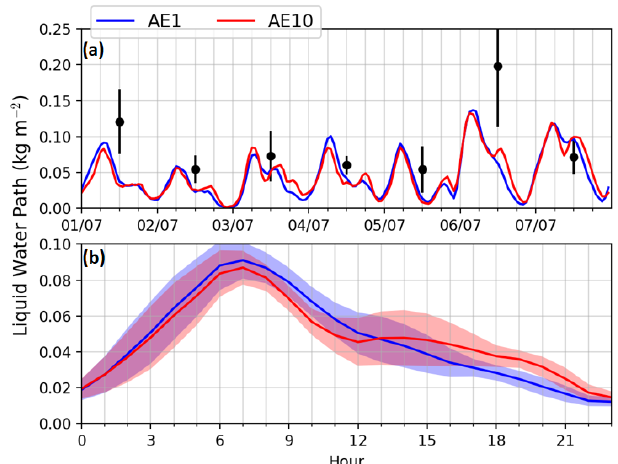
Figure 9. Time series of the vertical profile of modeled iso-contours of hourly liquid water mixing ratio (2.5 and 5 × 10 − 5 kgkg − 1 ) for the two experiments AE1 (light and dark blue) and AE10 (light and dark red) averaged over an inland area ranging from 7 to 9 ◦ N, and from 1 to 4 ◦ E for (a) the period 1–7 July 2016, and (b) means of each hour for this period.